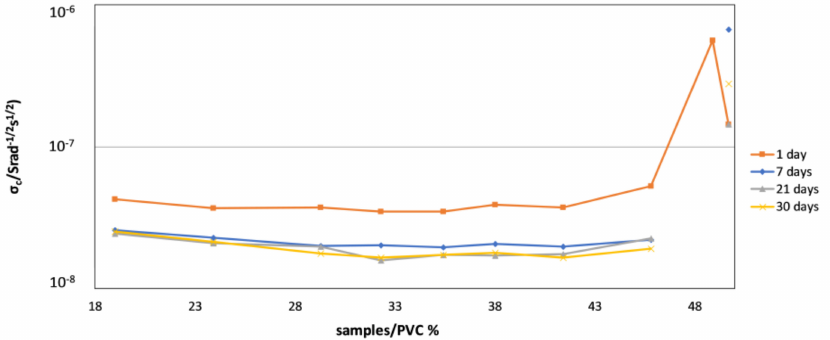
Figure 7. Warburg coeficient, σ c (see Equation (2)) as a function of PVC value and time of film formation for representative samples WB talc coatings